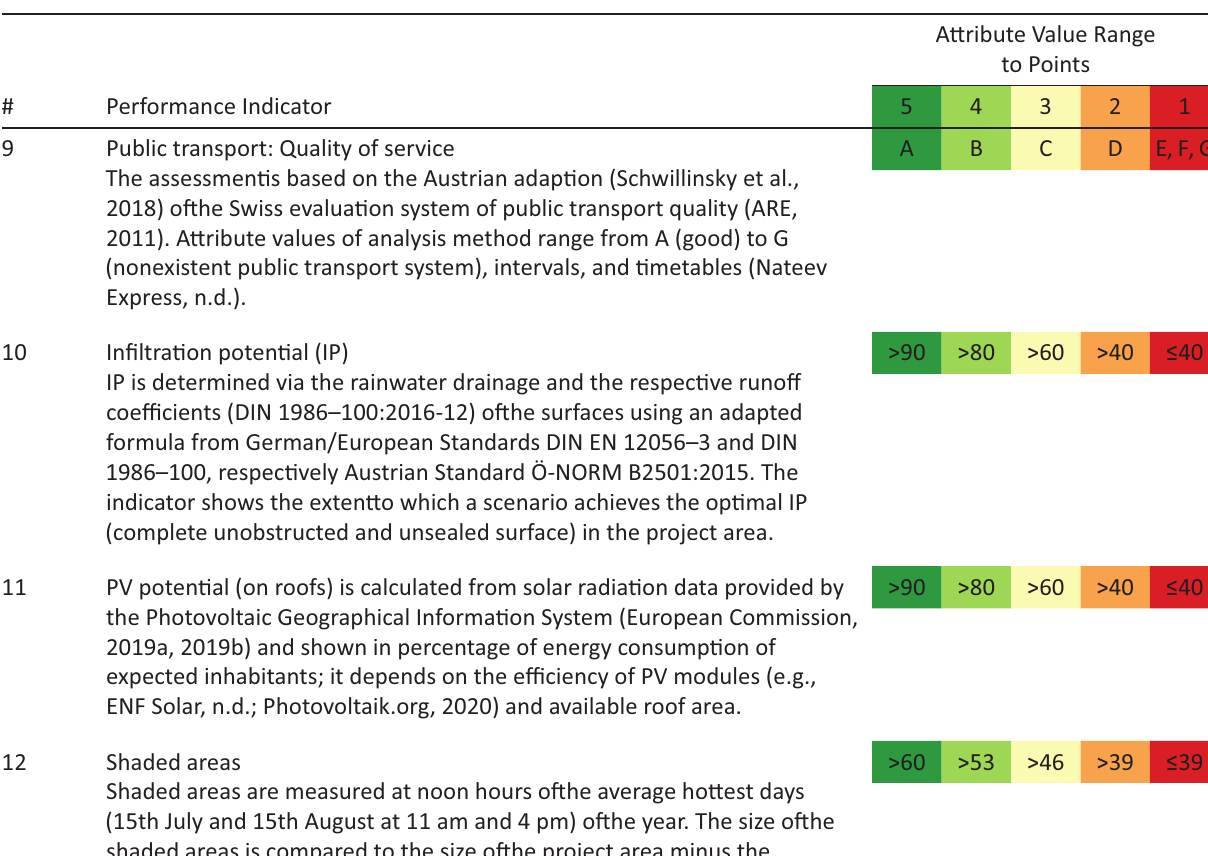
Table 2. Performance